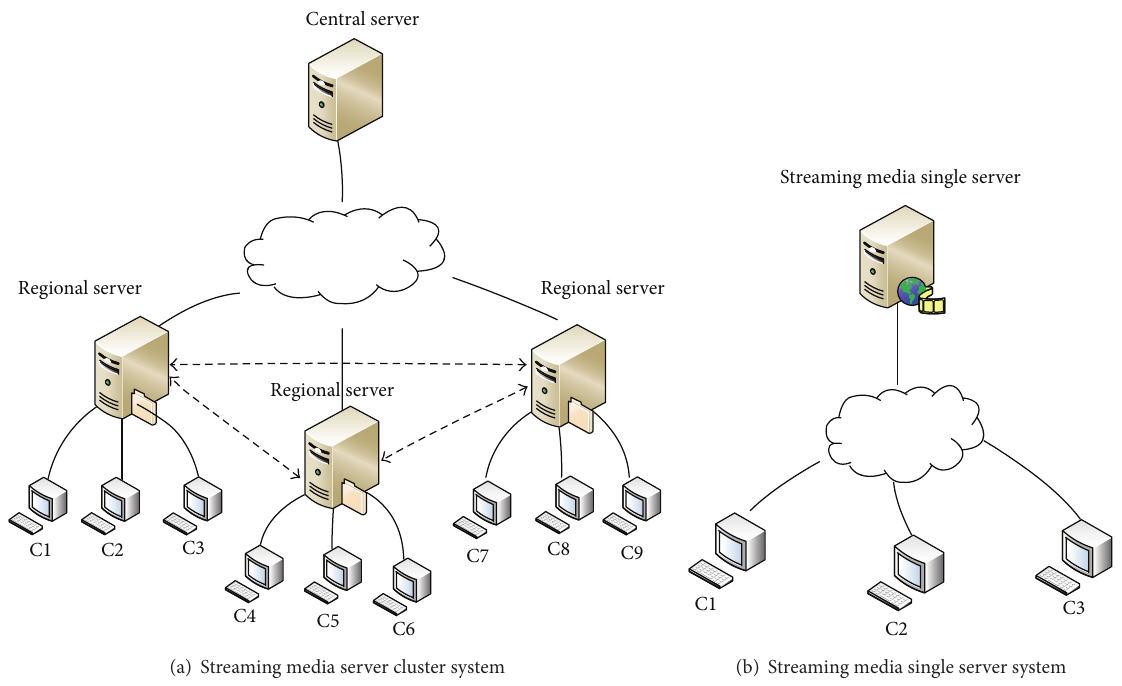
Figure 1: Two kinds of streaming media service system models.